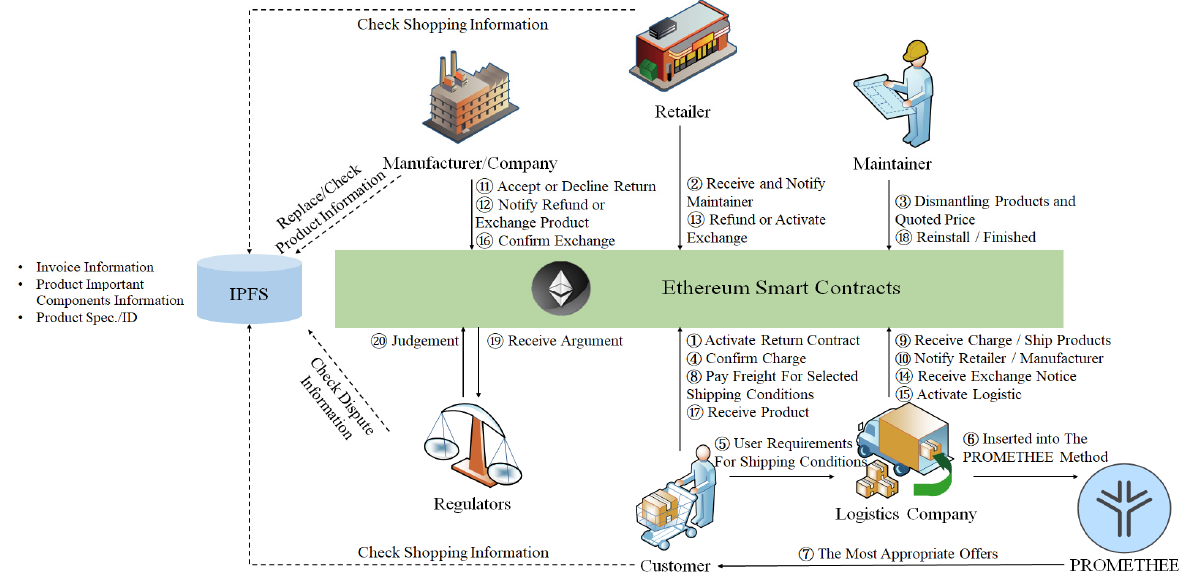
Figure 3. The proposed ESPRES system for return fraud prevention.